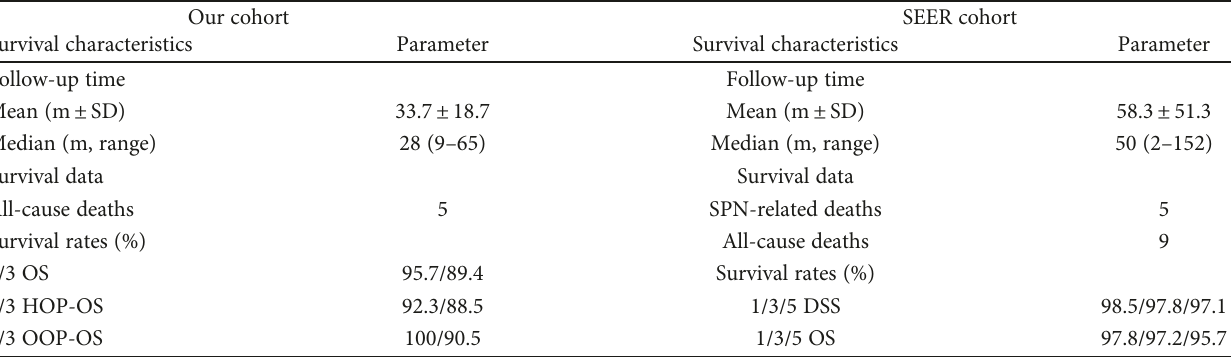
Table 2: Survival data of 188 SPN cases in our